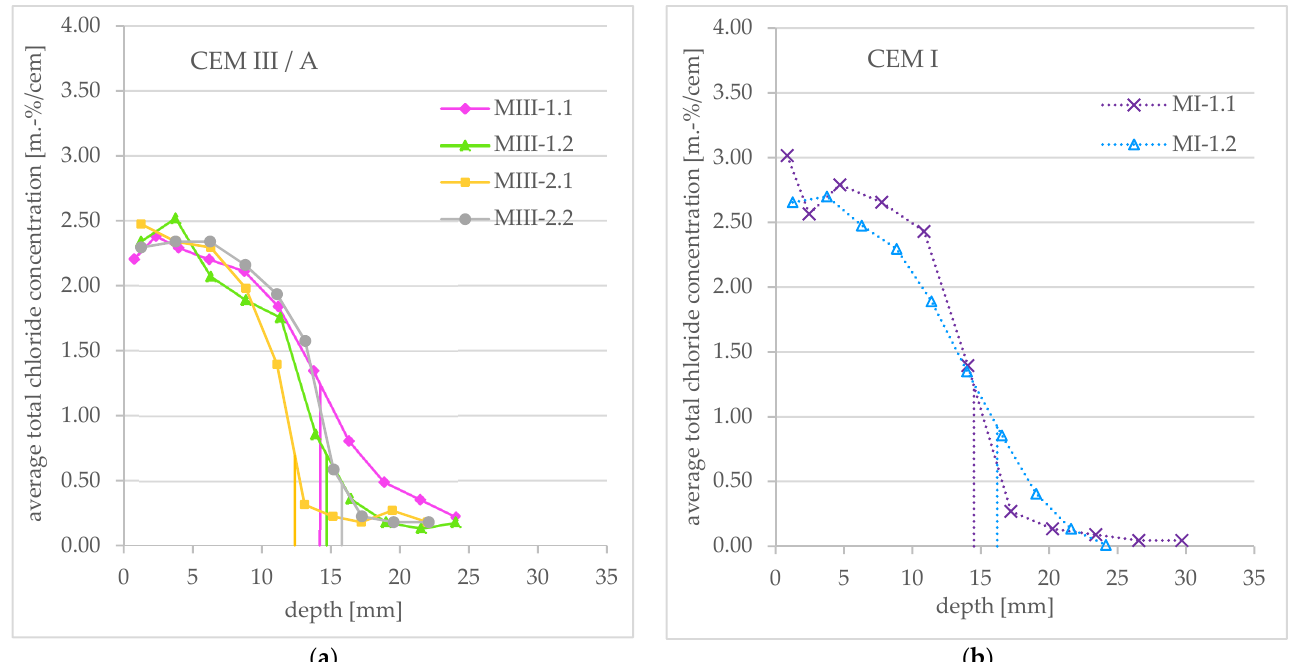
Figure 7. Total chloride concentration profiles obtained after an RCM test and average penetration depth (vertical lines) measured after spraying AgNO 3 ( a ) for CEM III/A mortar specimens and ( b ) for CEM I mortar